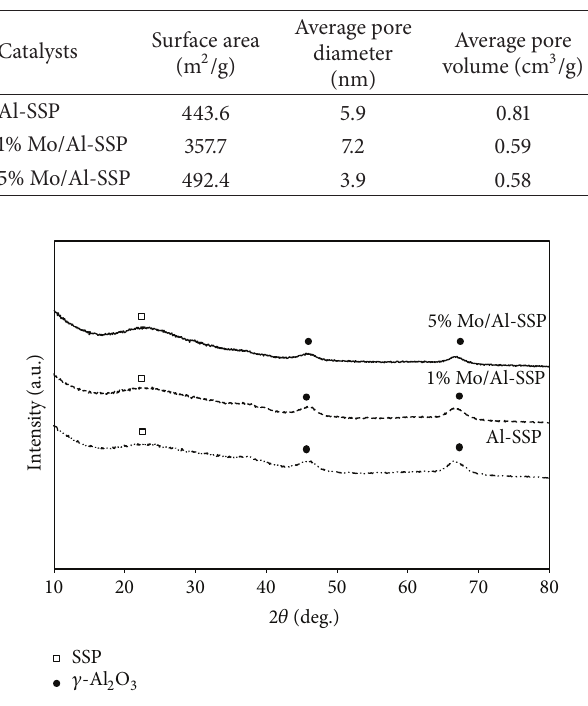
Figure 1: XRD patterns of all catalysts.